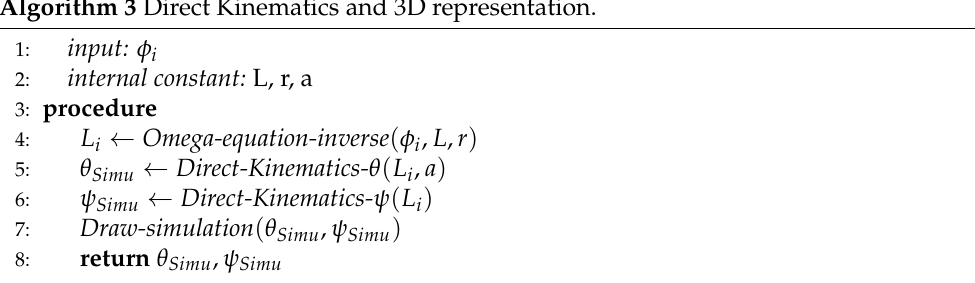
Figure 17. Three-dimensional representation of the simulation of the soft joint for different input values. Algorithm 3 Direct Kinematics and 3D